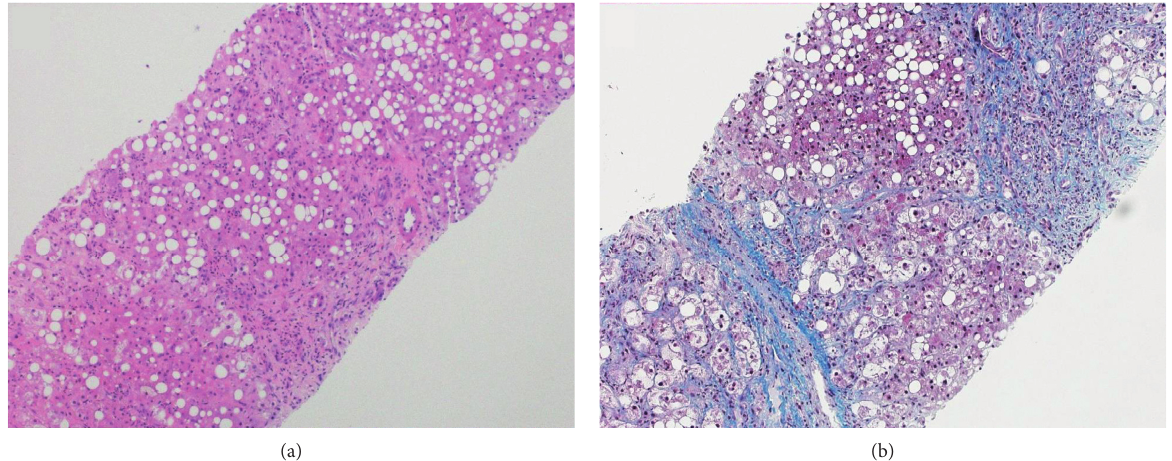
Figure 2: (a) Liver biopsy showing portal and perivenular fibrosis with severe bridging fibrosis and alcoholic hepatitis (hematoxylin & eosin stain, 200x). (b) Trichrome stain demonstrating severe fibrosis